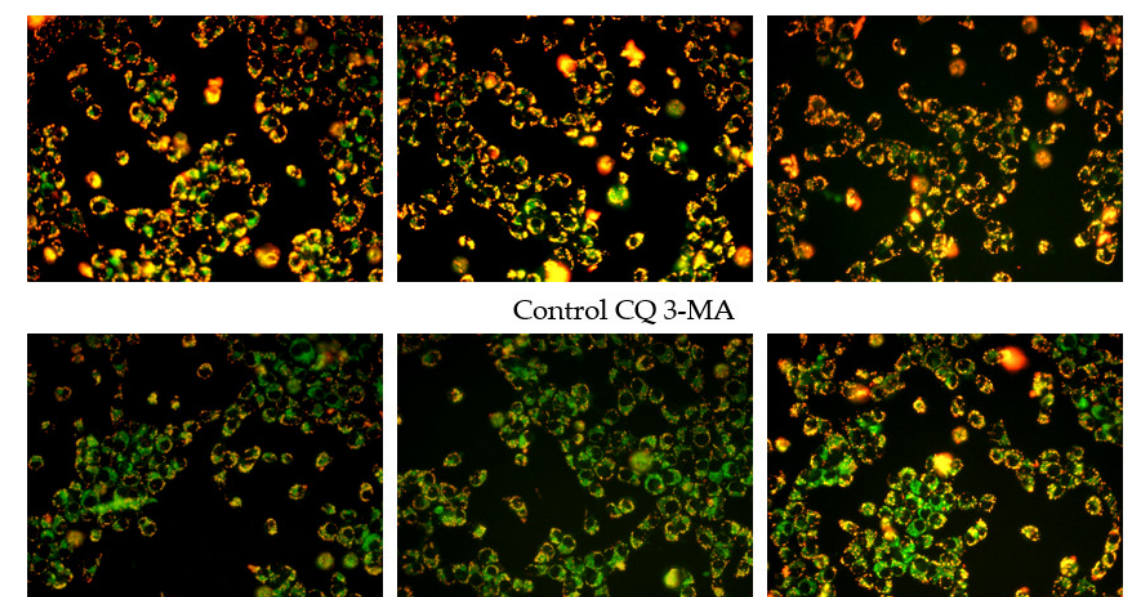
Figure 9. CQ and 3-MA attenuates the inhibitory effect of OF/PVP/PVA hydrogels by activating autophagy of Cal-27 cells. A: scratching assay; B: JC-1 staining.